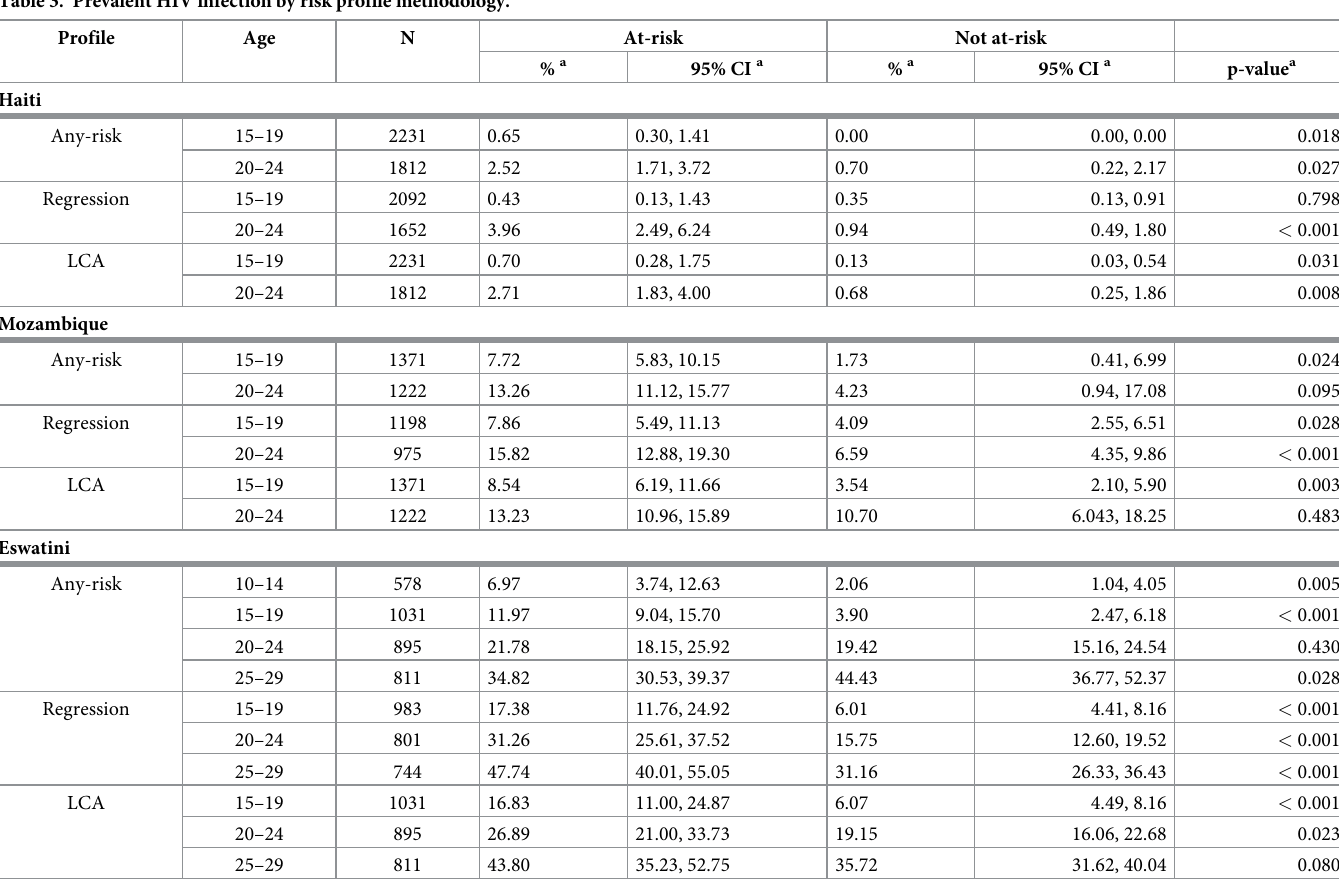
Table 3. Prevalent HIV infection by risk profile